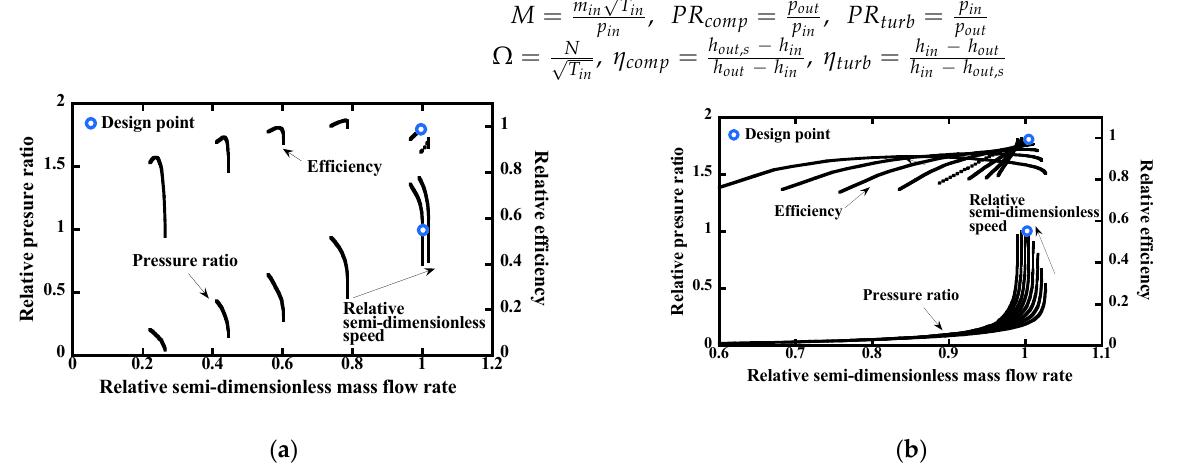
Figure 5. Normalized performance map of the gas turbine: ( a ) Compressor performance map; ( b ) Turbine performance map.